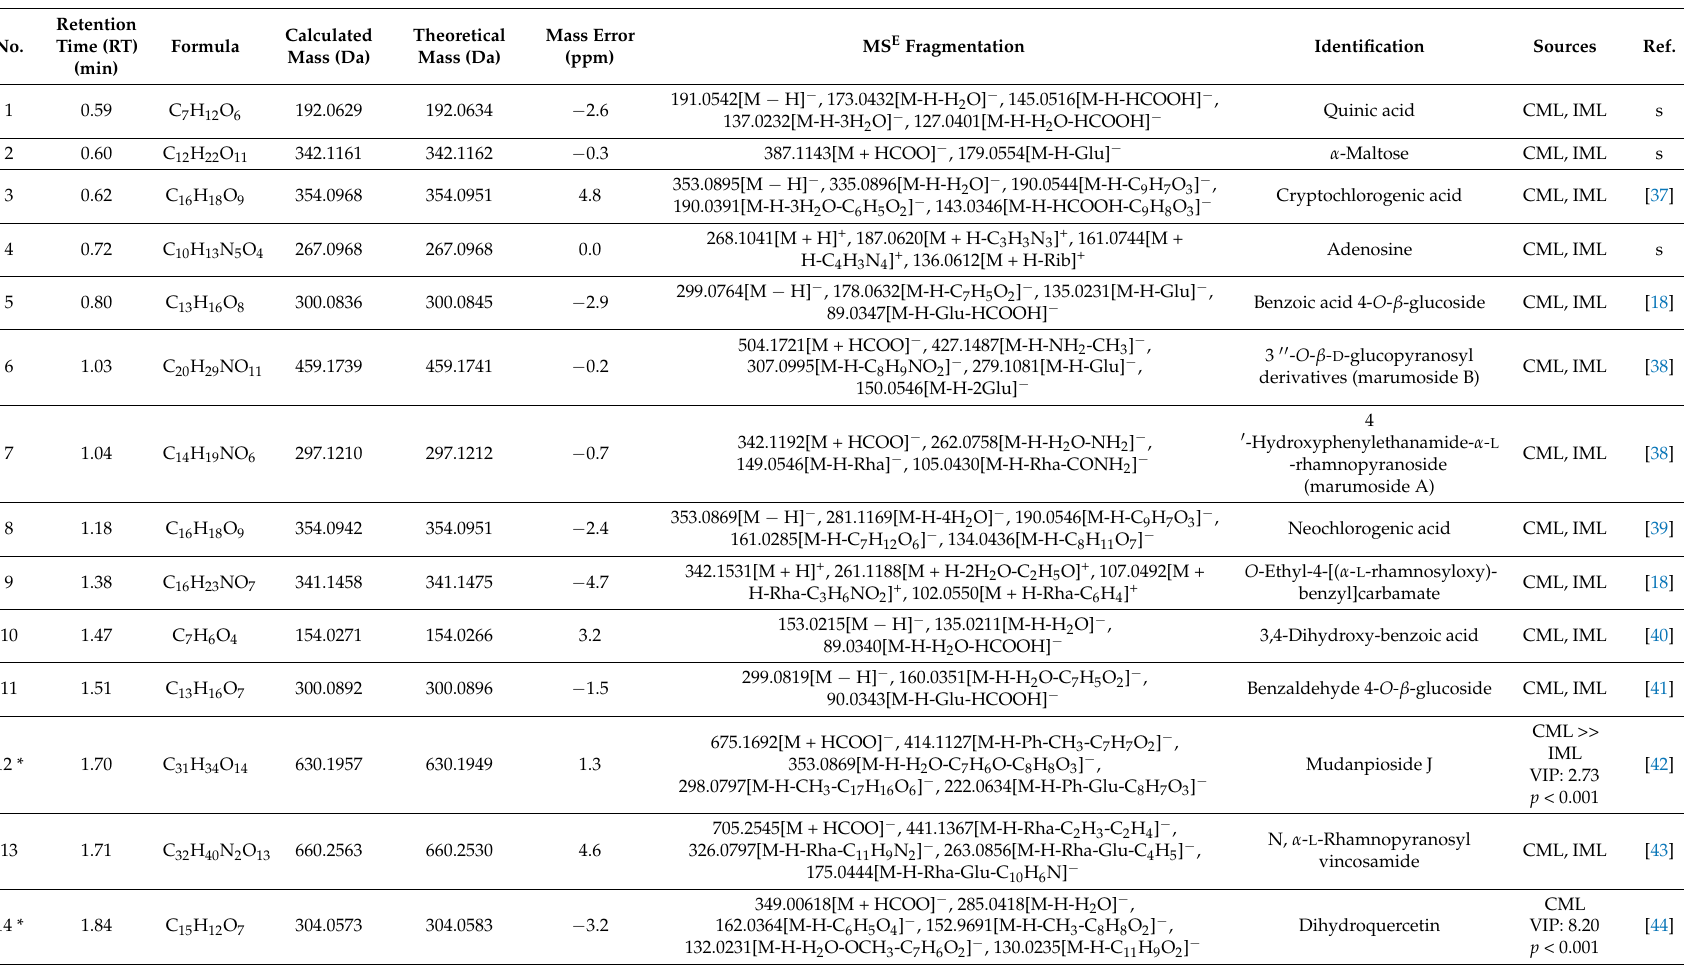
Table 2. Compounds identified from CML and IML by ultra-high-performance liquid chromatography quadrupole time-of-flight tandem mass spectrometry UPLC-QTOF-MS